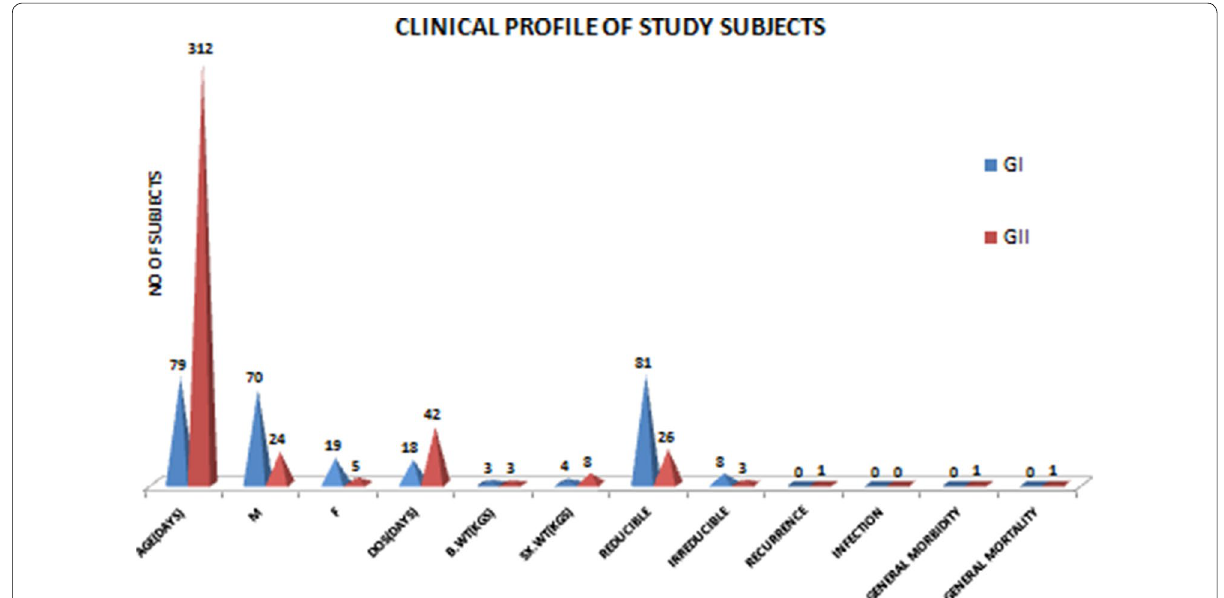
on the right side, that of 25% on the left side and that of 15% bilaterally [2, 3, 8, 9] (Fig. 3).